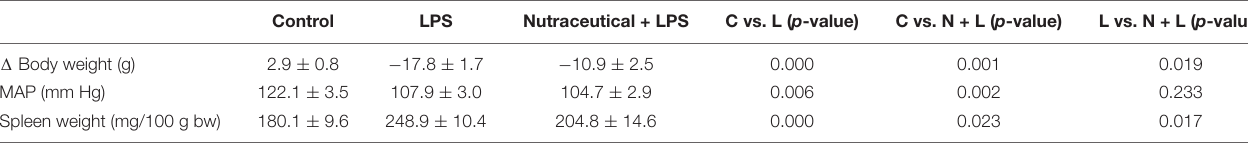
TABLE 1 | Body weight gain, mean arterial pressure (MAP) and spleen and gastrocnemius weights of rats treated with vehicle, LPS or LPS + Nutraceutical. Control LPS Nutraceutical +